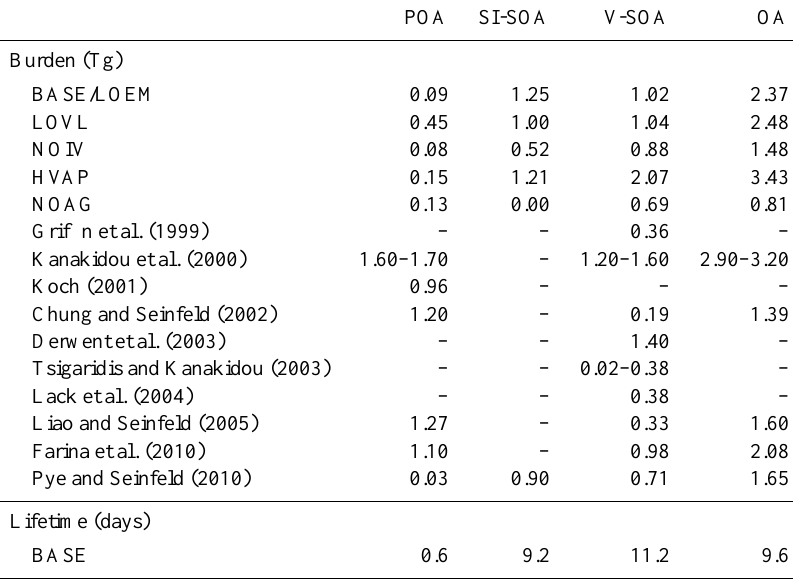
Table 4. Burden and lifetime for organic aerosol and its